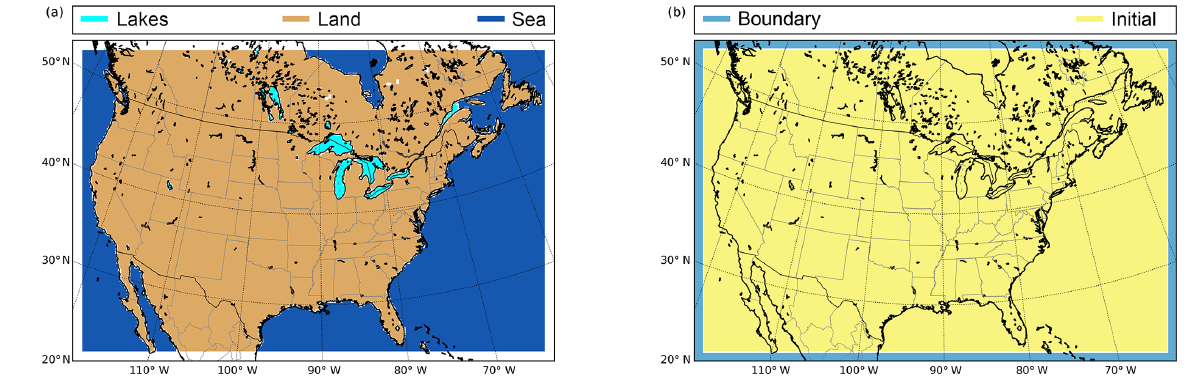
Figure 3. Moisture sources considered for validation calculations: two-dimensional (a) and three-dimensional (b) .